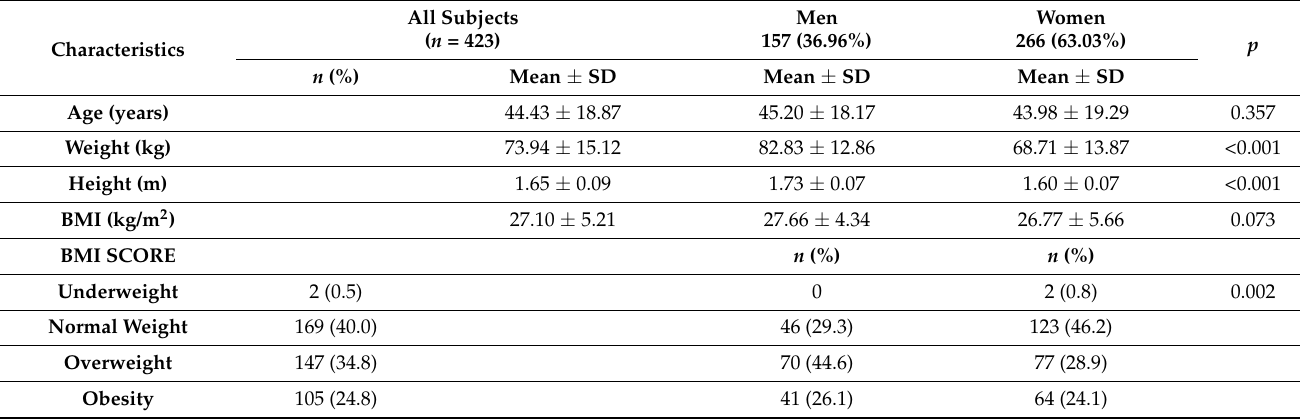
Table A1. Sociodemographic and anthropometric characteristics of the participants.